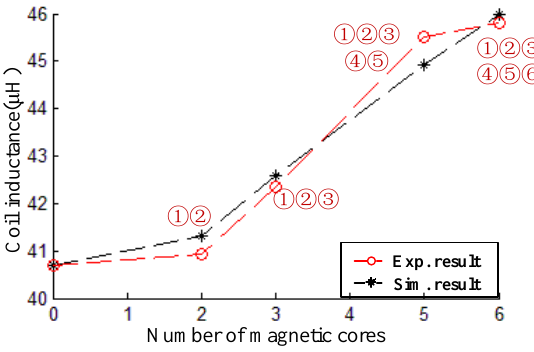
Figure 13. Effect of ferrite cores on inductance parameters of the receiving coil. Table 2. Receiving coil’s parameter variation.